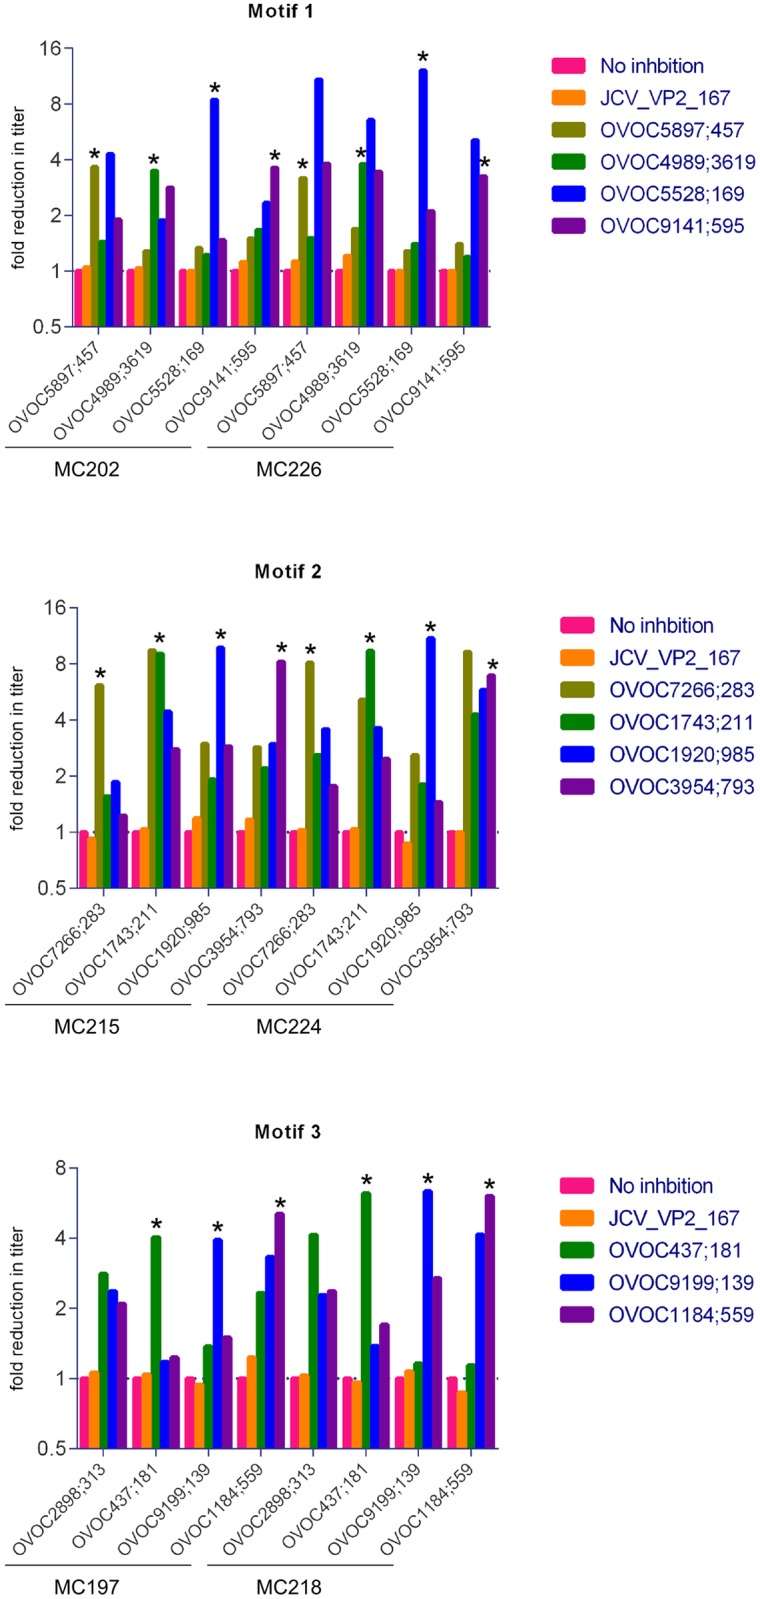
Reactivity in peptide ELISA can be inhibited by peptides with the same motif.Reduction in titer was determined by addition of non-biotinylated peptide to 2 different samples during incubation on the ELISA plates. Plates are coated with the biotinylated peptide as indicated in the x-axis. Titration curves were determined (S3 Fig) and titer was calculated as the dilution showing an Abs405nm that corresponds to 10-fold reduction in absorbance of the non-inhibited sample at the start dilution (i.e. 200-fold). As a negative control, the non-relevant peptide JCV_VP2_167-15mer was included. All self-inhibition results are indicated with *.